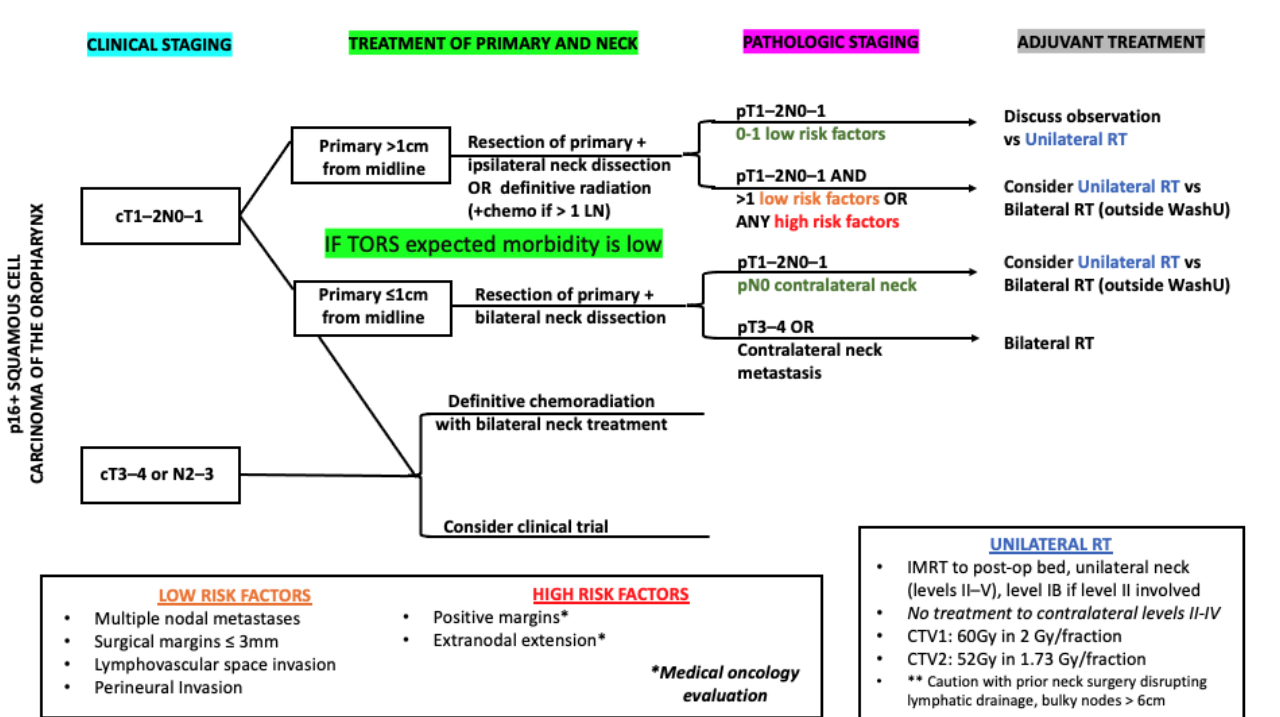
Figure 1. Proposed patient selection (on clinical trial) for unilateral neck RT for patients with p16+ squamous cell carcinoma of the oropharynx staged with PET/CT. * = Patients with tumor with positive margins and/or extranodal extension on pathology should be referred to medical oncology for evaluation for chemotherapy; ** = Unilateral radiation therapy should be delivered with caution in patients with prior neck surgery that disrupts lymphatic drainage